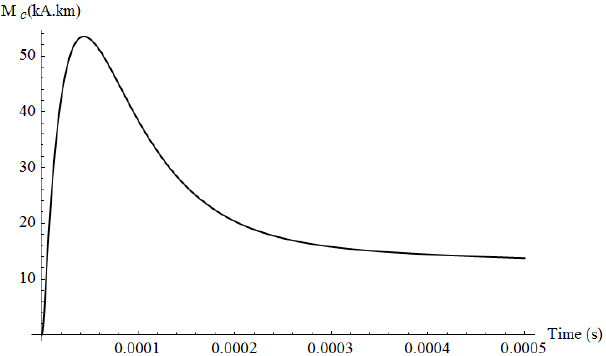
Figure 7: Magnetic field versus frequency at a distance of 1000 km from the